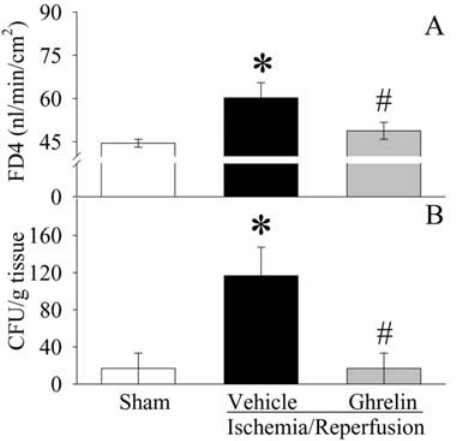
Figure 4. Alterations in intestinal mucosal permeability (A) to fluorescein isothiocyanate dextran with a molecular weight of 4000 Da (FD4) and bacterial translocation to mesenteric lymph nodes (B) in sham-operated animals (Sham) and ischemia/ reperfusion animals treated with normal saline (Vehicle) or ghrelin (Ghrelin) at 1.5 h after the completion of treatment (i.e., 2 h after reperfusion). Data are presented as means 6 SE (n=6), and compared by one-way ANOVA and Student-Newman-Keuls test: * P , 0.05 versus Sham group; # P , 0.05 versus Vehicle group.